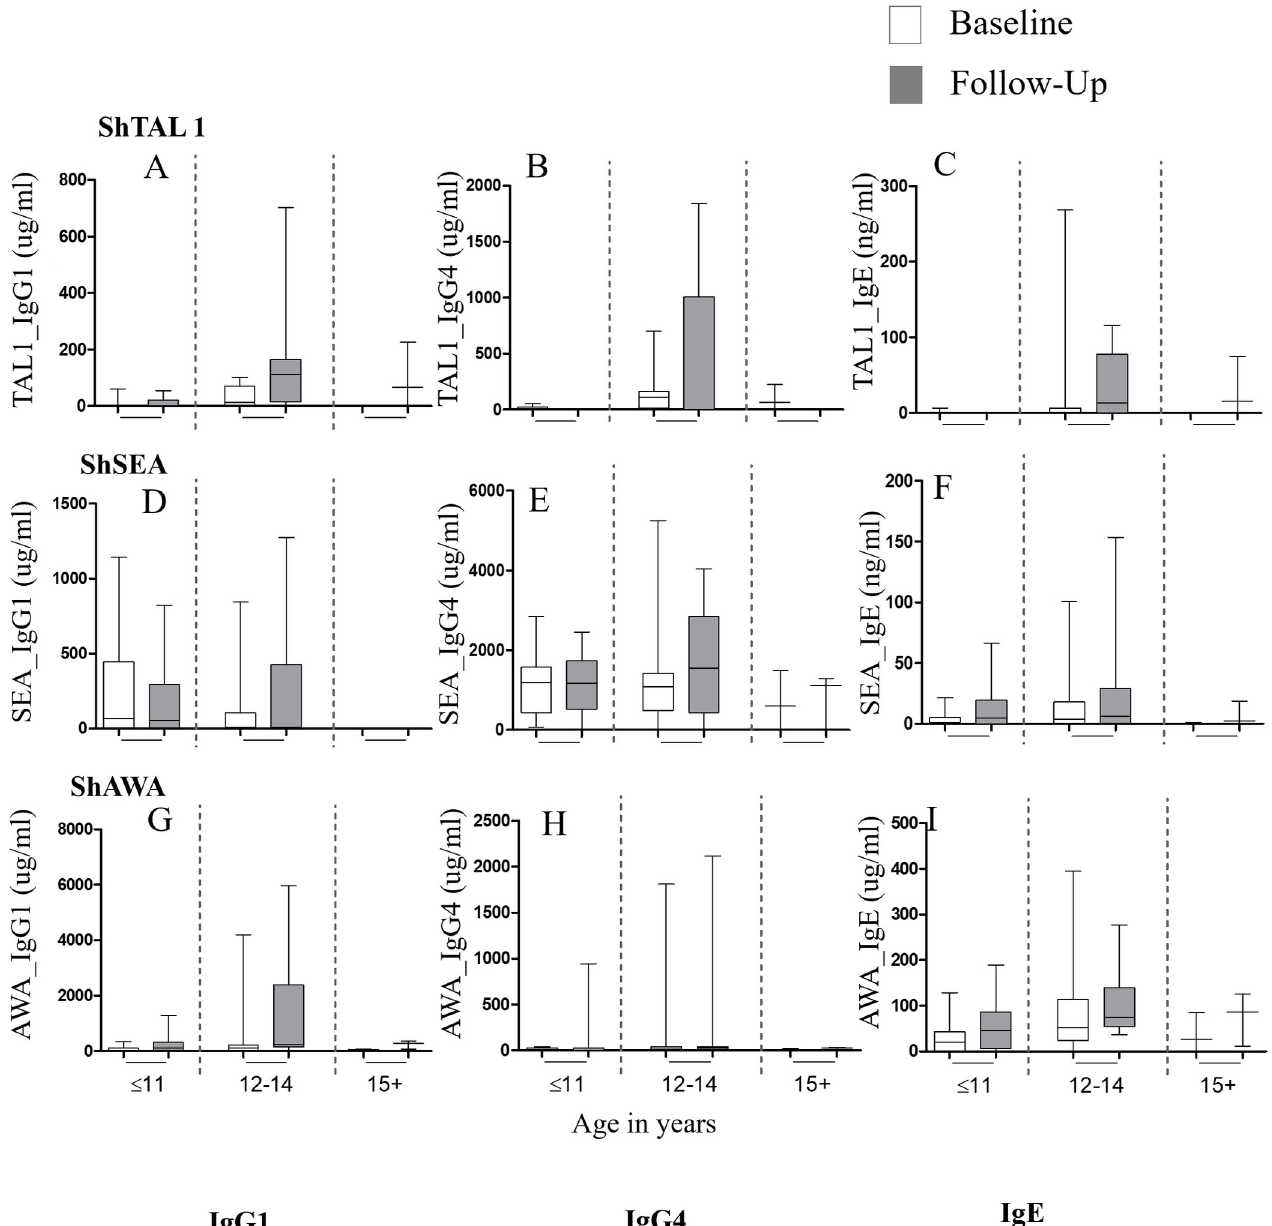
Fig 5. Association of median titres of S . haematobium -specific antibodies with age. Association of median titres of S . haematobium -specific antibodies (A– I) with age at baseline and Follow-up among participants infected with S . haematobium at baseline (N = 26). Horizontal lines within the boxes (or those bisecting whiskers) denote the median levels. The lower horizontal border of the box represents the 25 th percentile, whilst the upper boarder denotes the 75 th percentile. The upper and lower whiskers are set at the 95 th and 5 th percentiles respectively. The Wilkoxon Matched-Pairs Signed-Ranks test was employed in determining